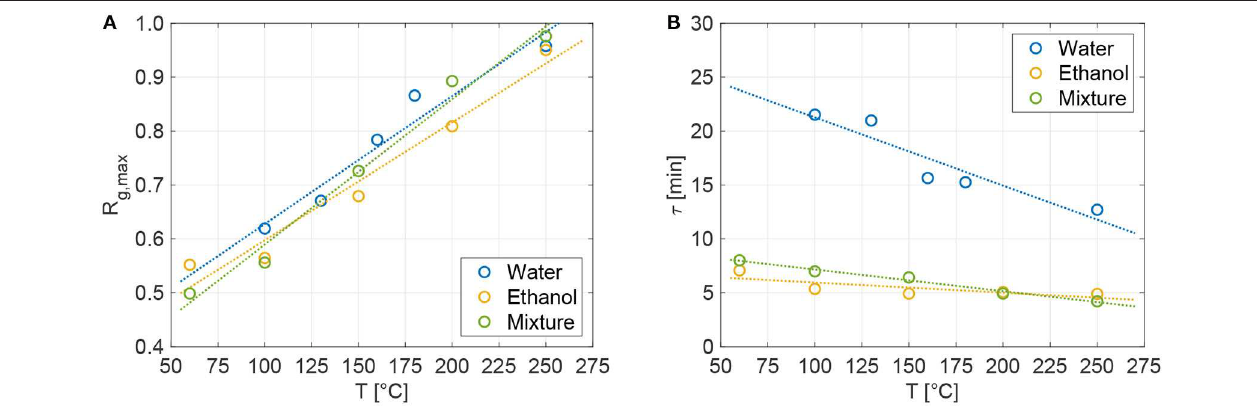
FIGURE 4 | (A) Maximum regeneration grade ( R g , max ) and (B) characteristic time (or time constant, τ ) of the dehydration process for the tested sorbates, obtained by best-fit of Equation (5) on the experimental series in Figures 3A–C . The dots correspond to the best-fitted values of R g , max or τ for the different temperatures and fluids, while the dotted lines are their linear